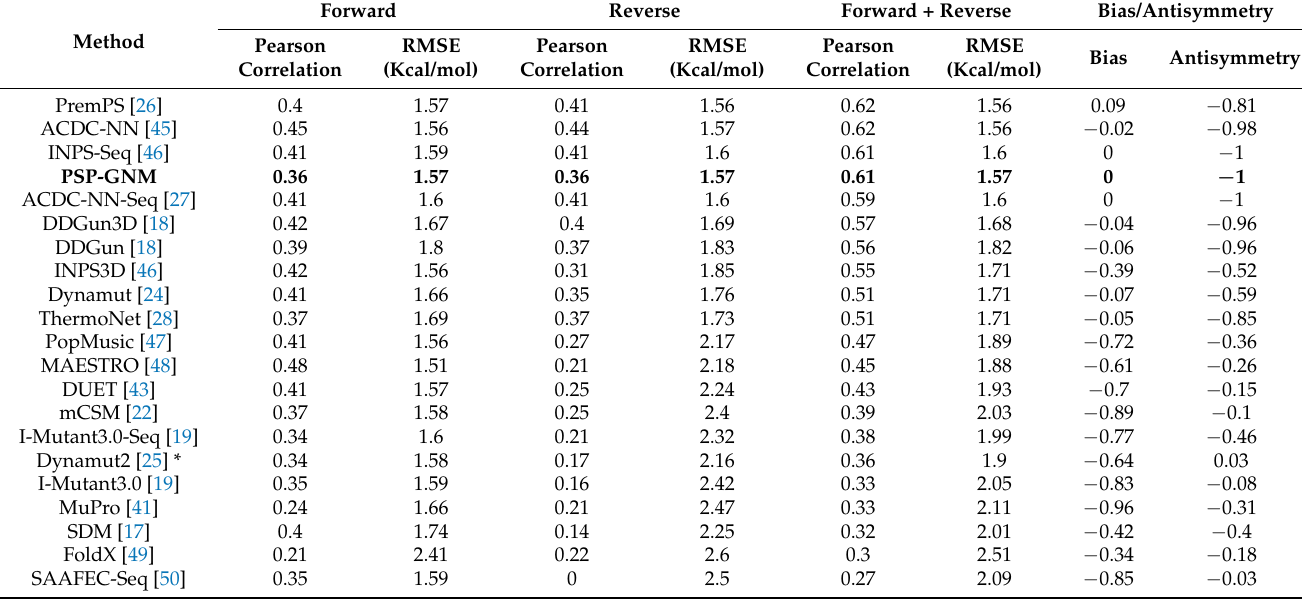
Table 7. Performance comparison on the S669 dataset for a subset of 584 mutations with a PSP-GNM- calculated ∆∆ G. The table is sorted by Pearson correlation in the Forward + Reverse category. The performance for PSP-GNM is shown in bold.